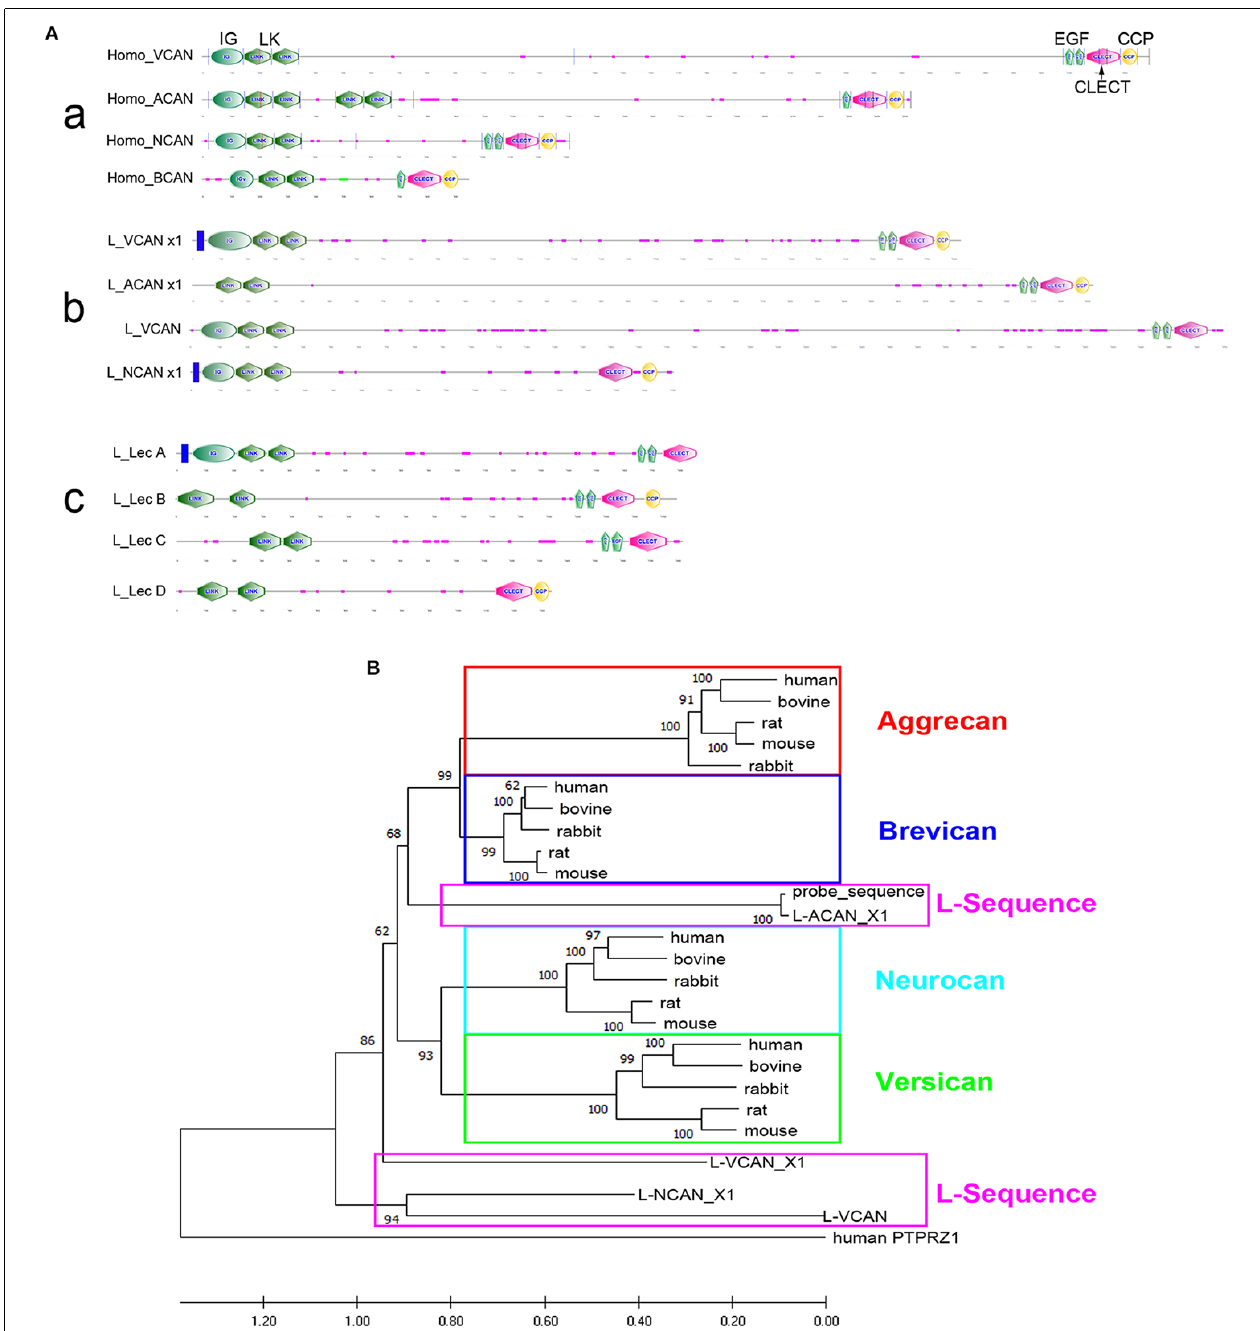
FIGURE 5 | Structural comparison and molecular phylogeny of vertebrate lecticans. (A) Domain structures of human ( a ) and lamprey lecticans ( b,c ) with the N-terminus to the left. IG = Immunoglobulin-like domain; LK = link domains; EGF = EGF-like domains; CLECT = C-type lectin domain, also known as the carbohydrate-recognition domain (CRD); CCP = complement control protein domain. The orders of each lamprey lectican annotated by Gnomon ( b ) correspond to lectican A, B, C, and D ( c ). (B) Phylogenetic relationships of mammalian and lamprey lecticans based on amino acid sequence alignments. Lamprey sequences are in pink boxes; the individual members of the mammalian lecticans are in other colored boxes. Maximum likelihood analysis scores are shown at the respective nodes. Human PTPRZ1 sequence is designated as an outgroup. The accession numbers for all sequences can be found in Supplementary Table 1 .